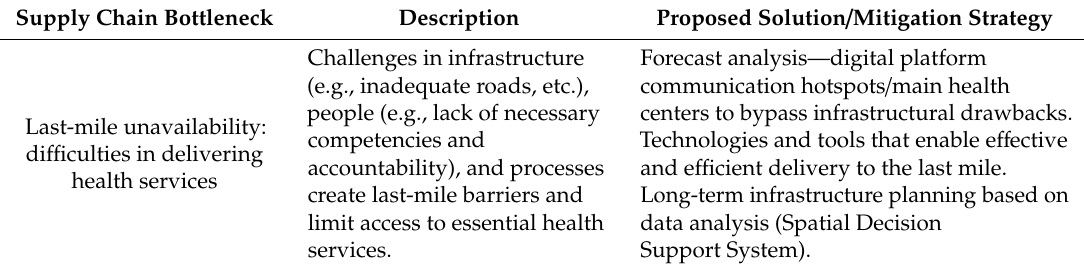
Proposed Solution / Mitigation